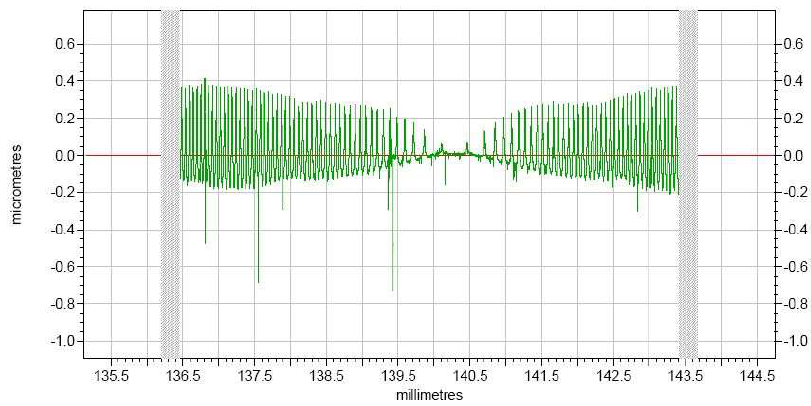
Figure 18. The measured values of compound freeform surface roughness.